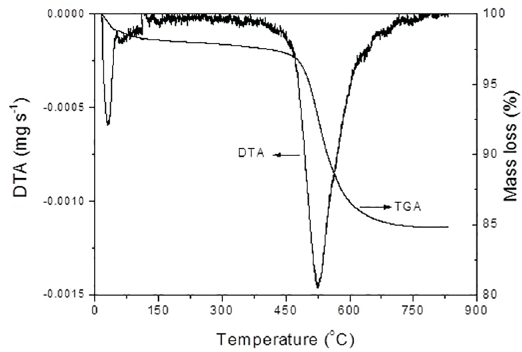
Figure 4. DTA and TGA curves of natural kaolin.